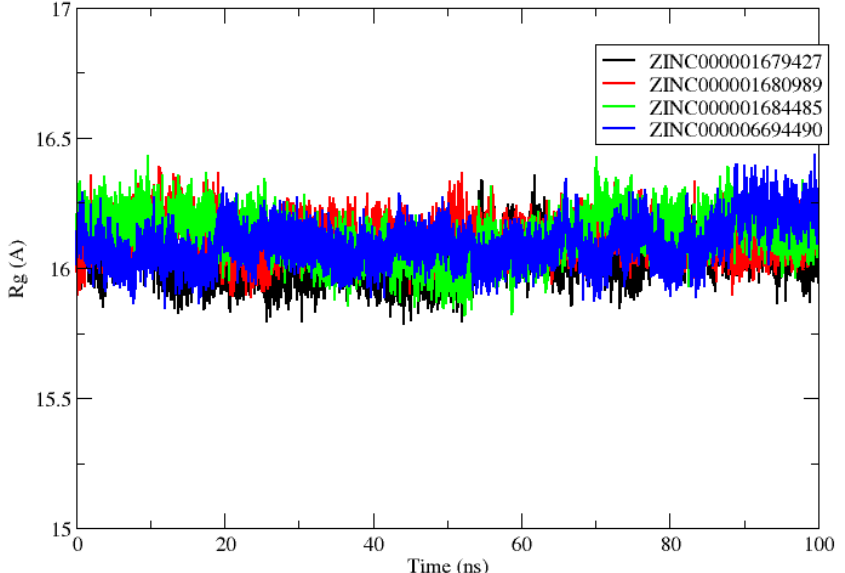
Figure 5. Radius of gyration (Rg) of the NS2B/NS3pro ZINC000001679427 (black line), ZINC000001680989 (red line), ZINC000001684485 (green line) and ZINC000006694490 (blue line) complexes studied.